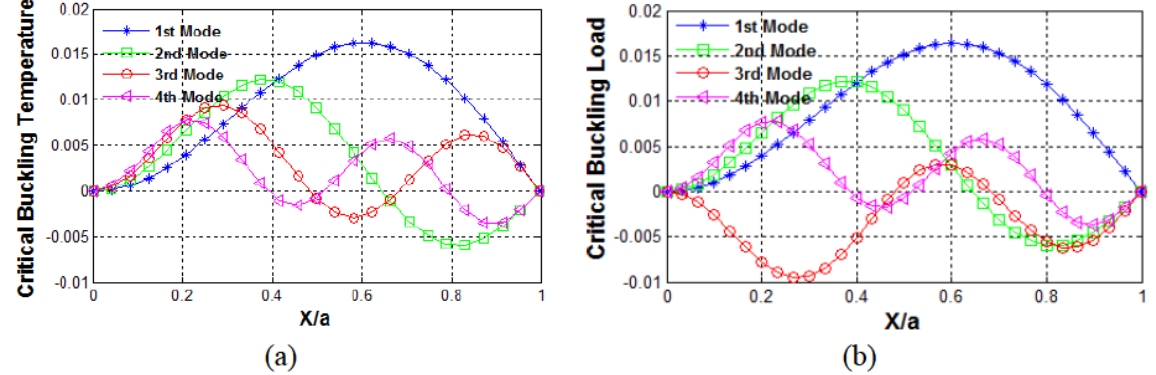
Figure 10: Buckling mode shape of SWCNTRCLB (a) with VIATL (b) with VIAML